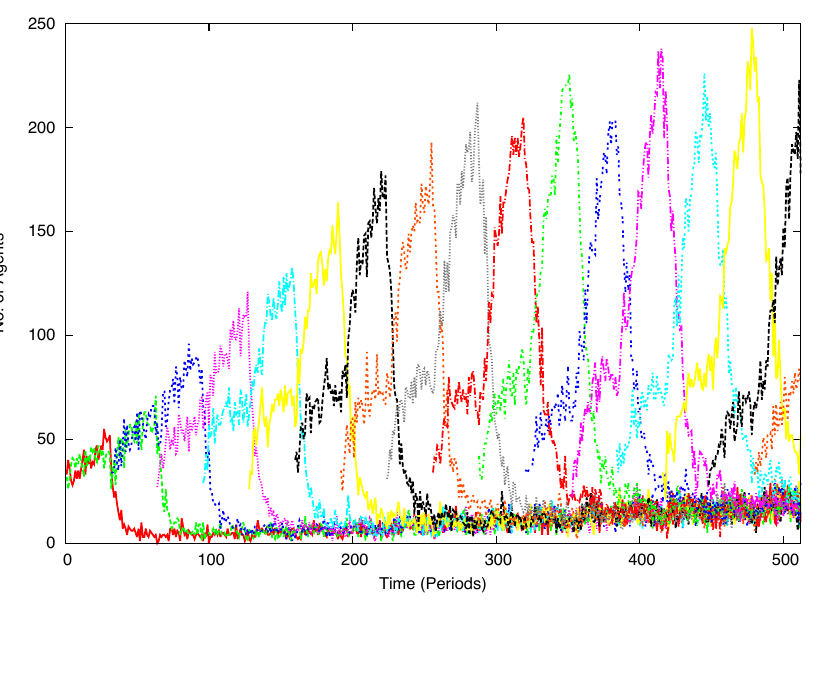
Figure 8. Development of the number of adherents to the different institutions (shown in different colors) for ↵ = 2 . 0 , with interactions being limited to agent’s neighborhoods on a regular grid network (compare to Figure